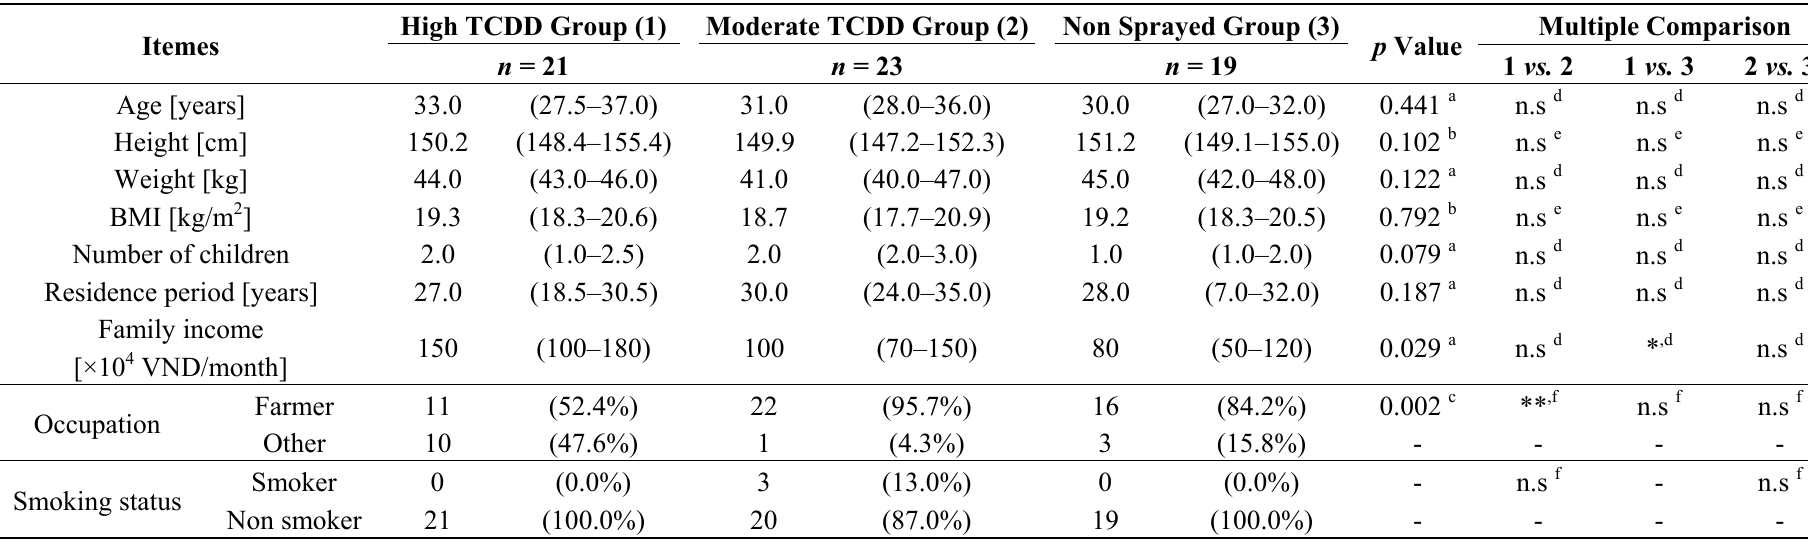
Table 1. Characteristics of subjects from the high and moderate TCDD (tetrachlorodibenzo-p-dioxin) groups and the non sprayed group. Itemes